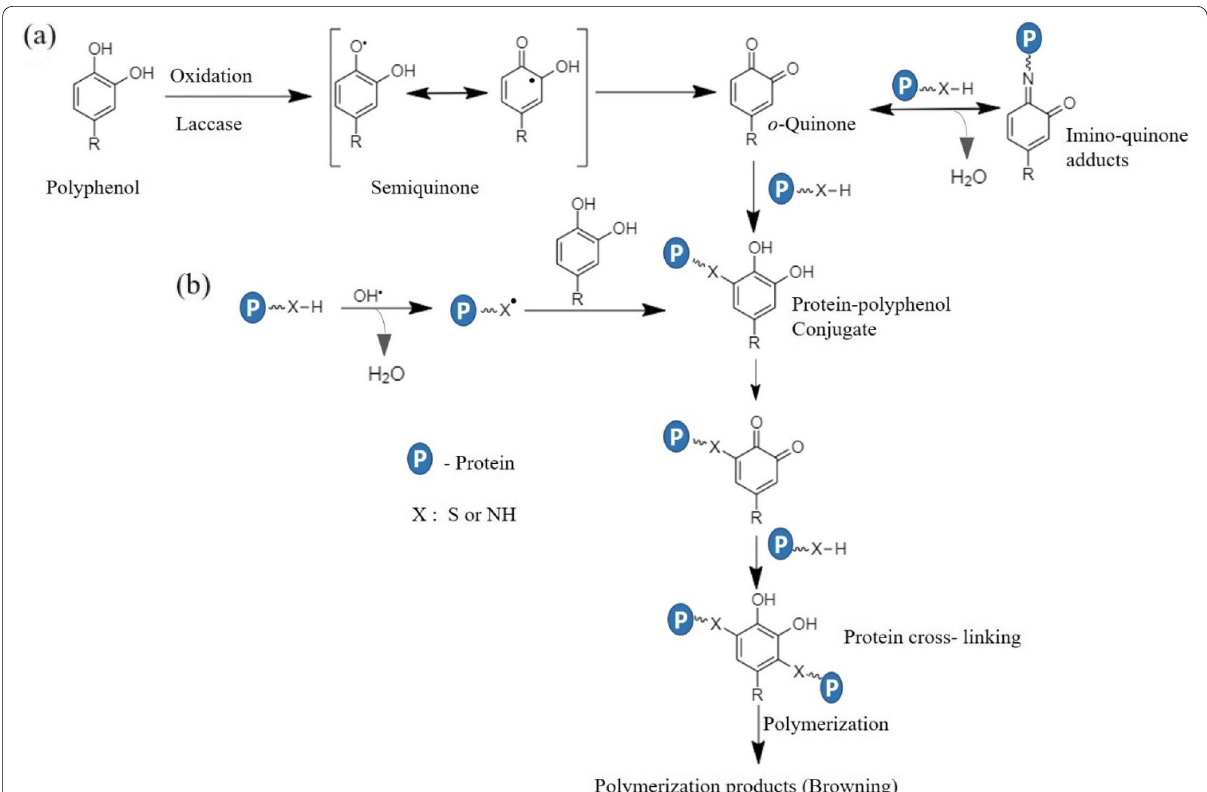
Fig. 6 Covalent bonding of polyphenols with protein. a Polyphenol-protein complexes formed by oxidation process - Michael addition and imino-quinone adducts. b Polyphenol-protein complexes formed by a free radical mediated process (Adapted from Li, He, et al. 2021; Li,